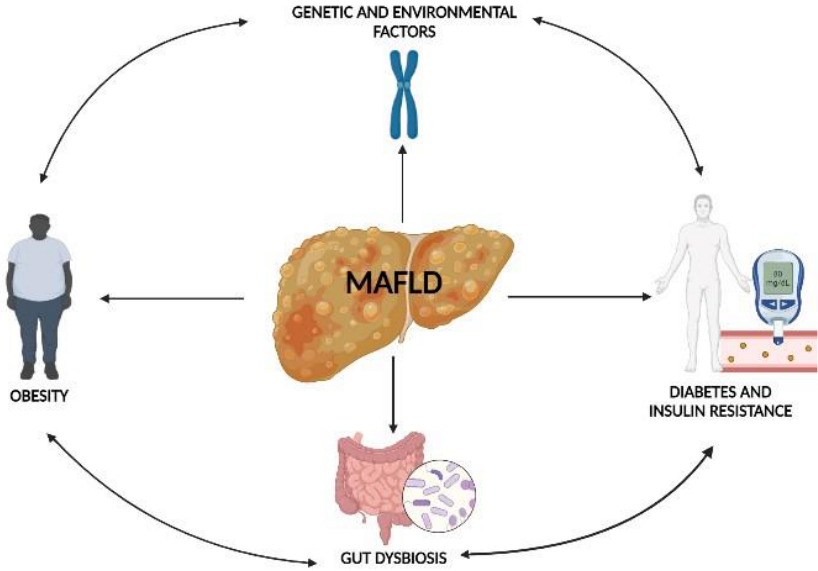
Figure 3. “Multiple-hit” hypothesis in MAFLD pathogenesis.